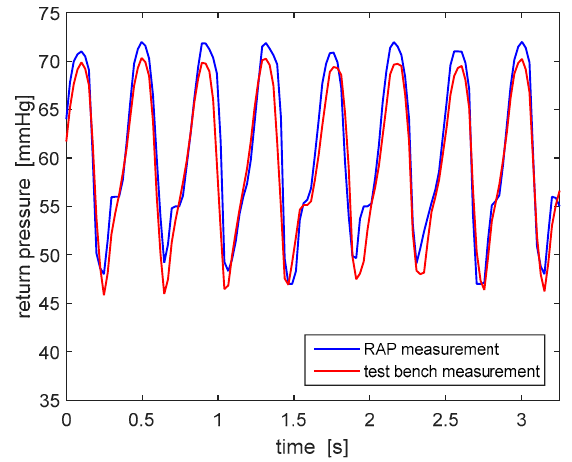
Figure 9. Return pressure values measured by RAP and test bench.